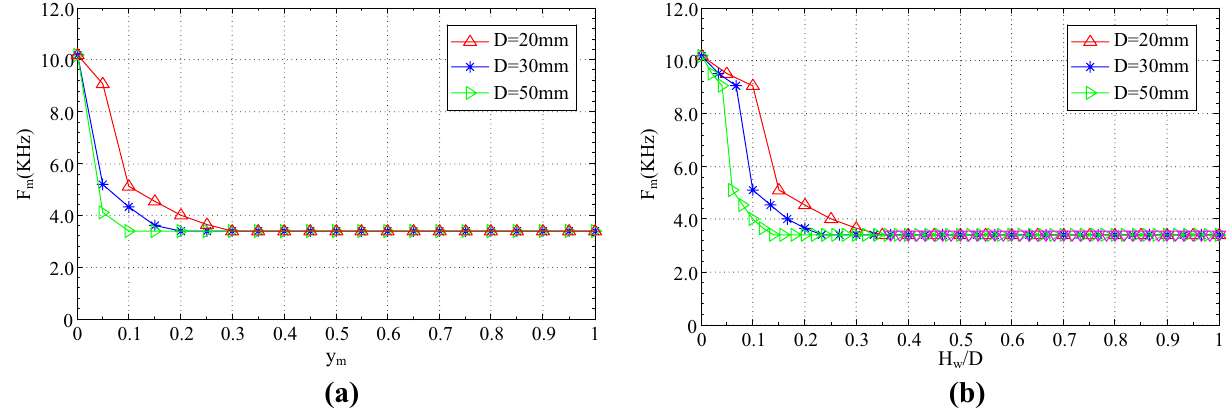
Fig. 13 Frequency response curves of MCP S = 4 mm: a F m versus y m , b F m versus H w